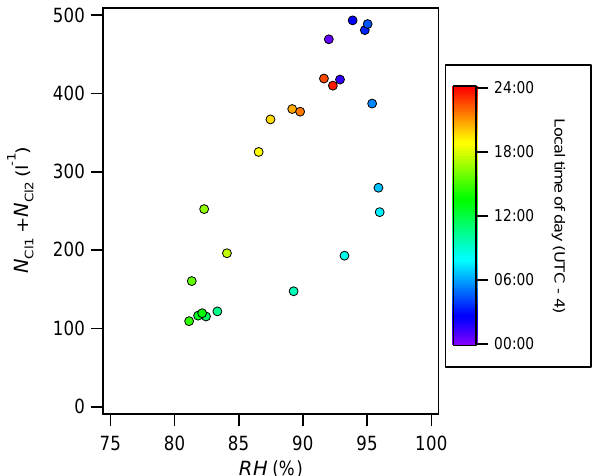
Figure 11. Diurnal means of total particle number concentrations in clusters 1 and 2, plotted against